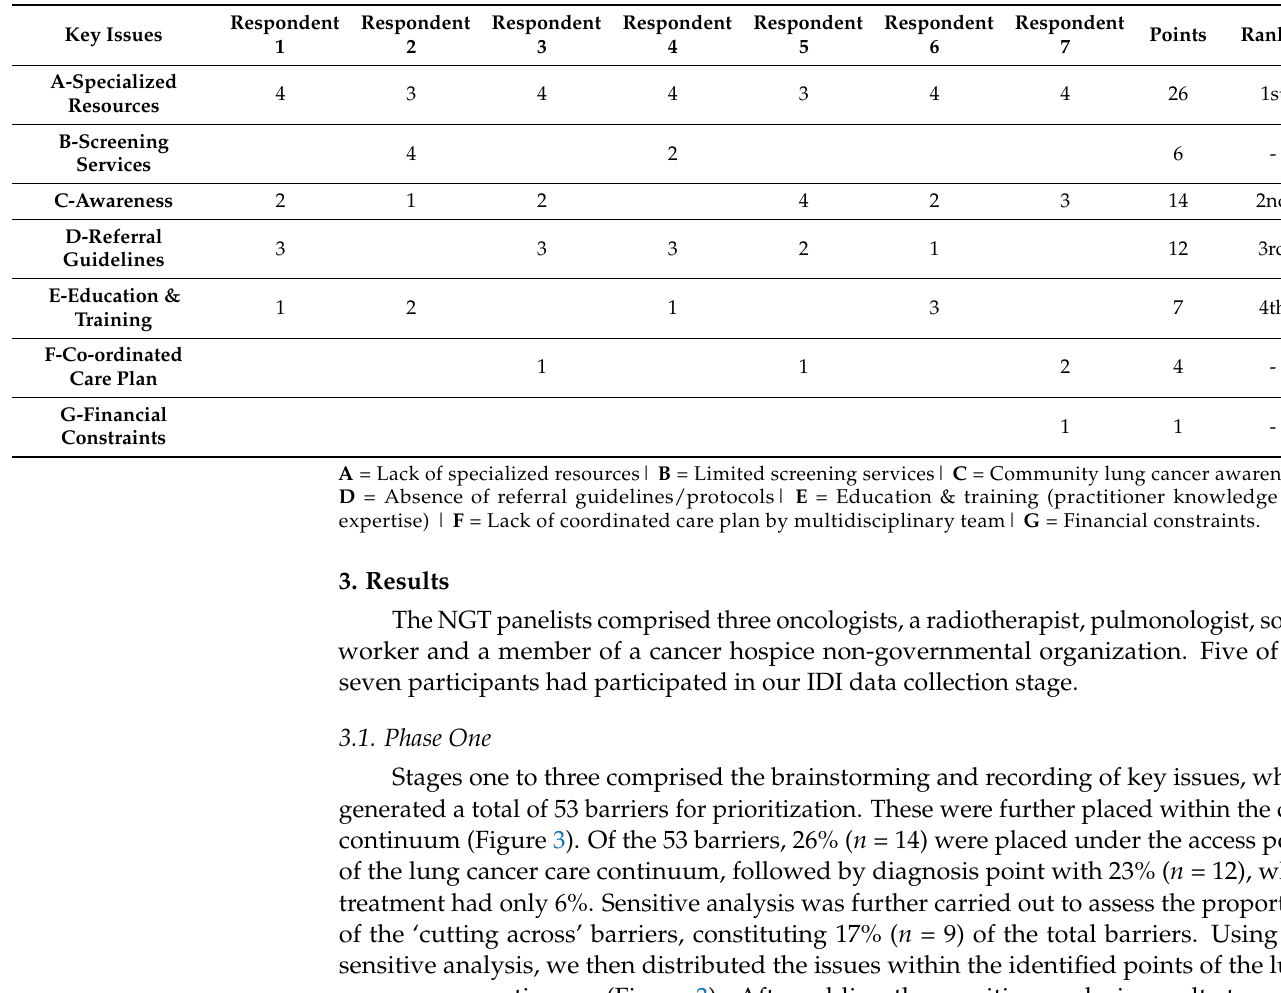
Table 1. Top Priority Issues as Identified by NGT Session of Healthcare Providers (Phase 2 & 3).